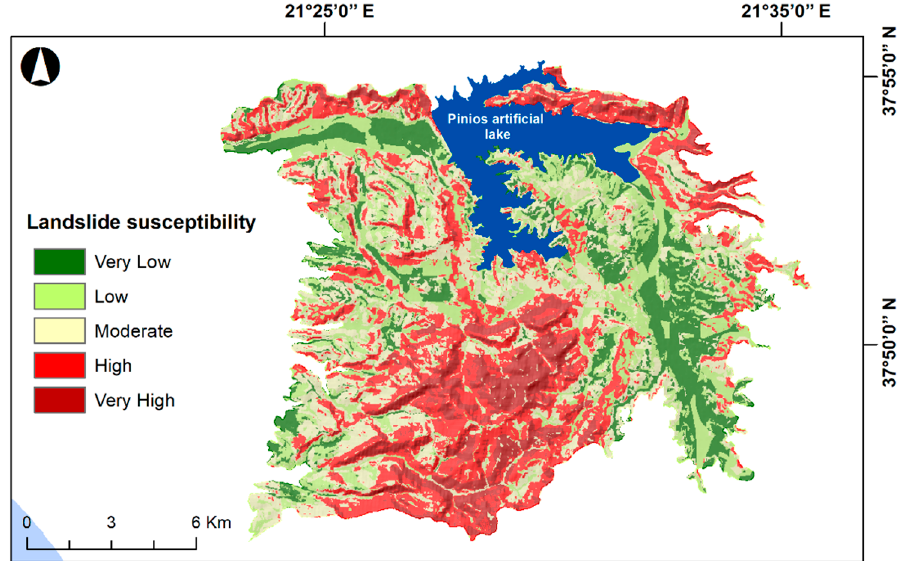
Figure 6. The landslide susceptibility map produced by the hybrid GeoDIV model.